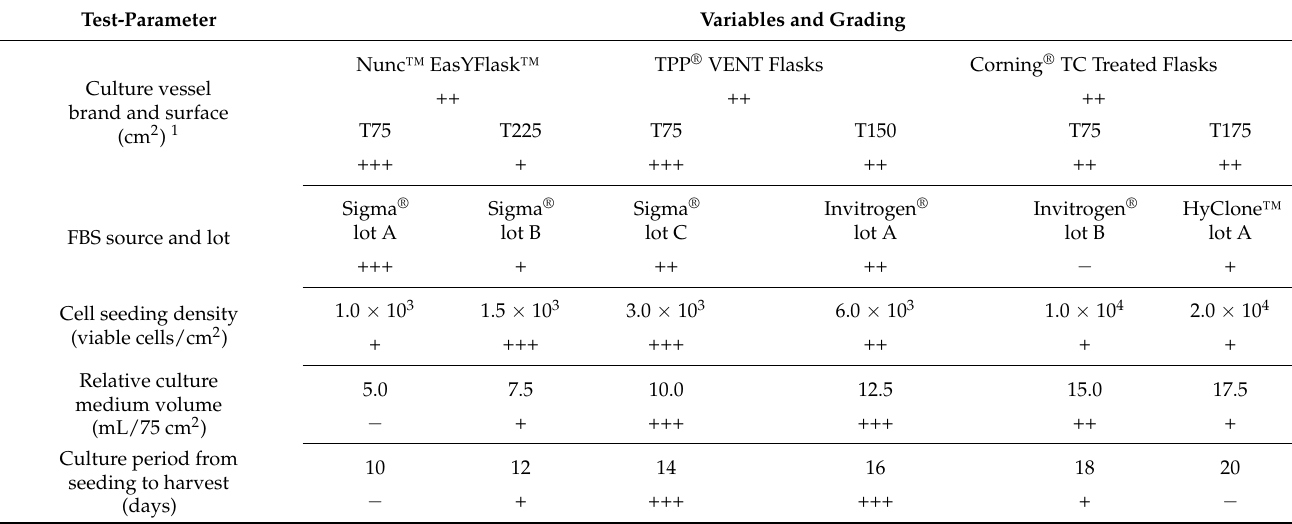
Table 1. Results of multi-parameter optimization and grading of culture conditions or specifications for large-scale manufacturing of hFPT cell bank lots. Optimal culture vessels were selected based on hFPT behavior in culture and endpoint cell yields. TPP ® surfaces were chosen over Nunc ™ surfaces due to supply chain issues. Optimal FBS sources were chosen based on endpoint cell yields and availability of large commercial lots. Optimal cell seeding densities, culture medium volumes, and culture periods were selected based on hFPT behavior in culture, endpoint cell yields, and cost- to-benefit ratios (i.e., sparing use of cell seed stocks, consumables, and manufacturing suite use). ( − ) = unsatisfactory, (+) = sub-optimal, (++) = satisfactory, (+++) = optimal. FBS, fetal bovine serum; hFPT, human fetal progenitor